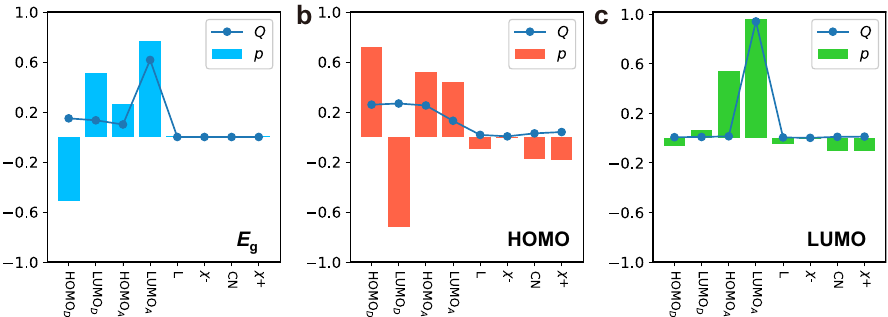
Fig. 5 Feature analysis via machine learning. Correlation coef fi cients ( p ) and feature importance ( Q ) as a function of the structural features for E g ( a ), HOMO ( b ) and LUMO ( c )